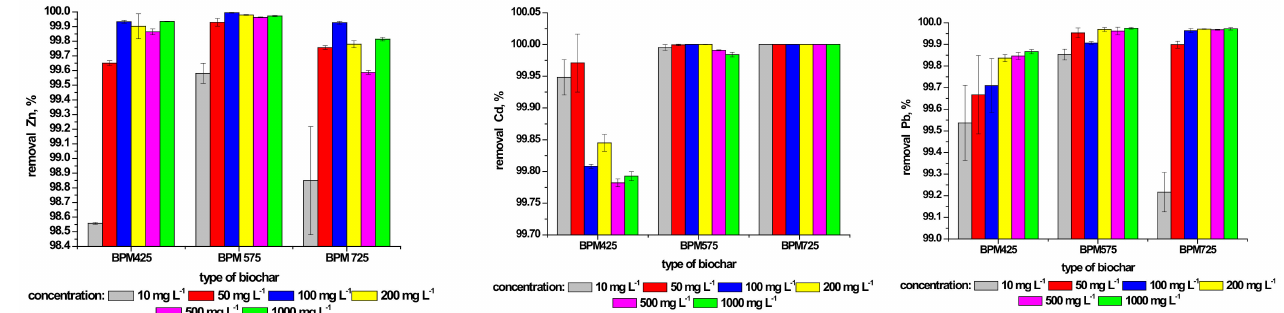
Figure 3. The removal of Zn, Cd and Pb (%) determined for the produced biochars in relation to the initial concentration of selected metal in the